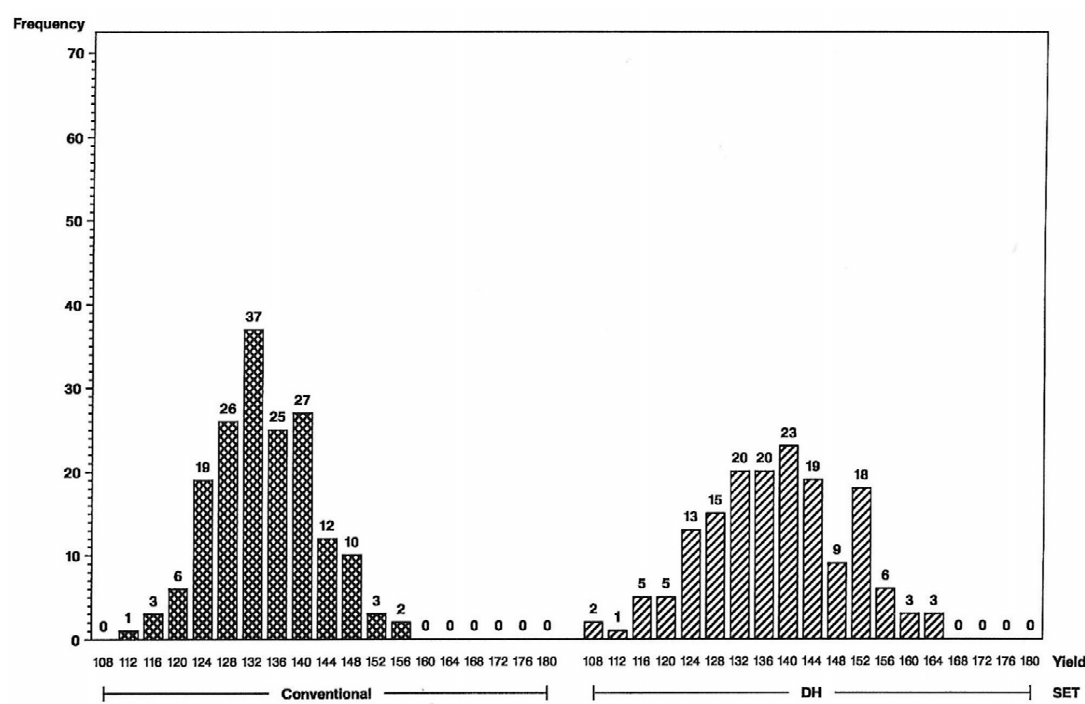
Figure 1. Frequency distributions for maize hybrid grain yields in bushels per acre (on x -axis) using the L inbred tester, conventional S2 line-hybrids on the left and DH line-hybrids on the right. Numbers of hybrids are above the bars.